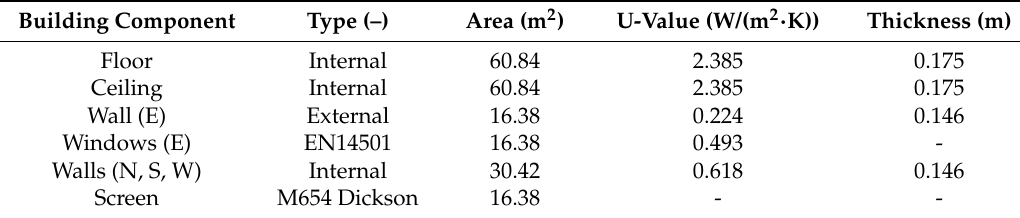
Table 2. Thermal transmittance for the building components (used in IDA-ICE).